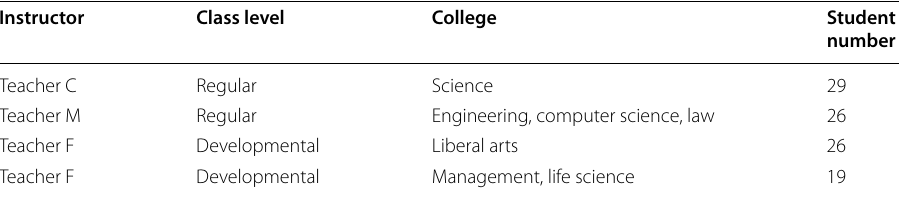
Table 1 Number of students for each